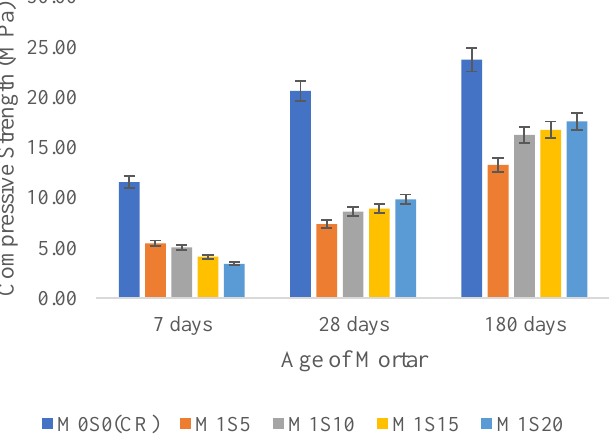
Figure 12. Effects of SF content on the compressive strength of 1% SDPMF mortars.